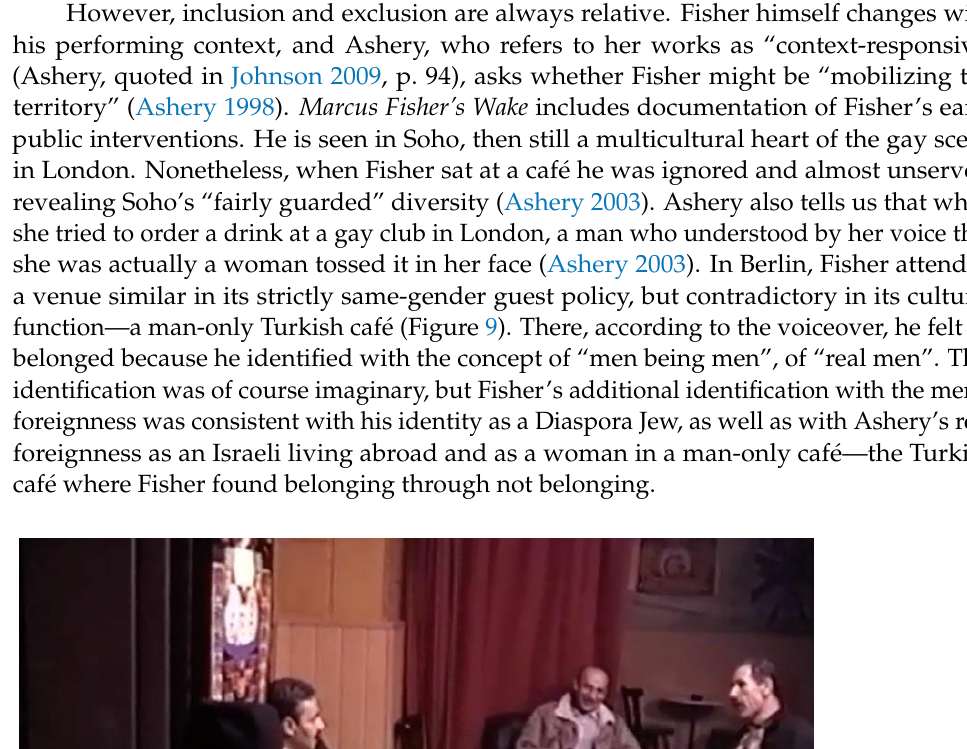
Figure 8. Oreet Ashery, Marcus Fisher I , circa 1998. Courtesy of the artist.